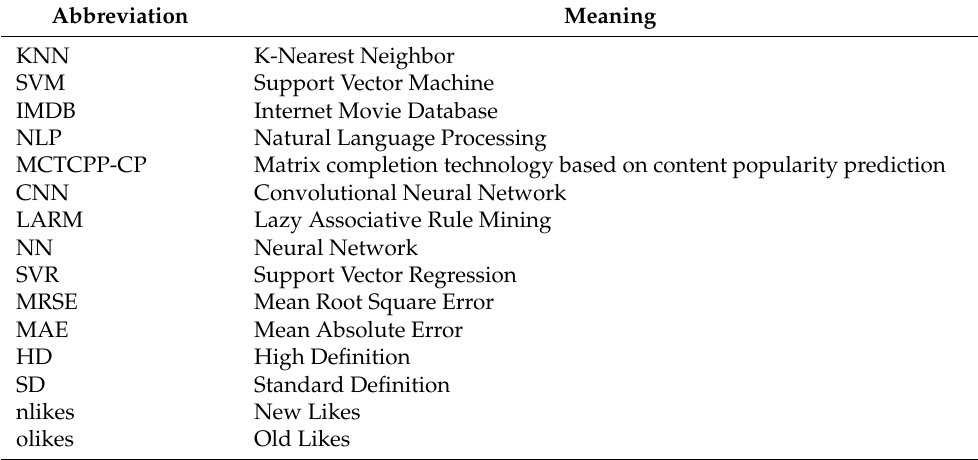
Table 1. List of